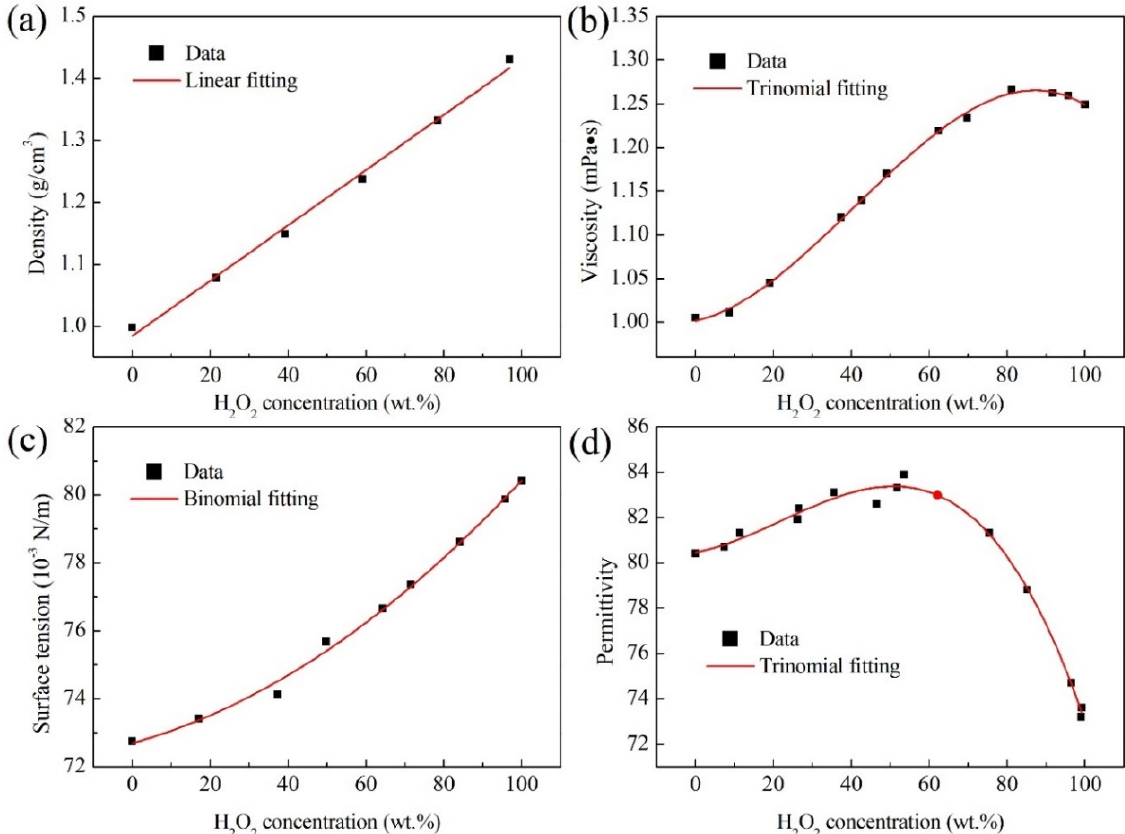
Figure 1. The physical properties of H 2 O 2 solutions at the room temperature of ~20 °C. ( a ) Density; ( b ) Viscosity; ( c ) Surface tension; ( d ) Relative permittivity.